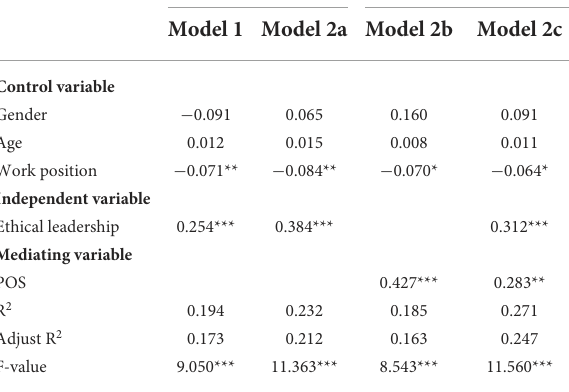
TABLE 1 Results of regression